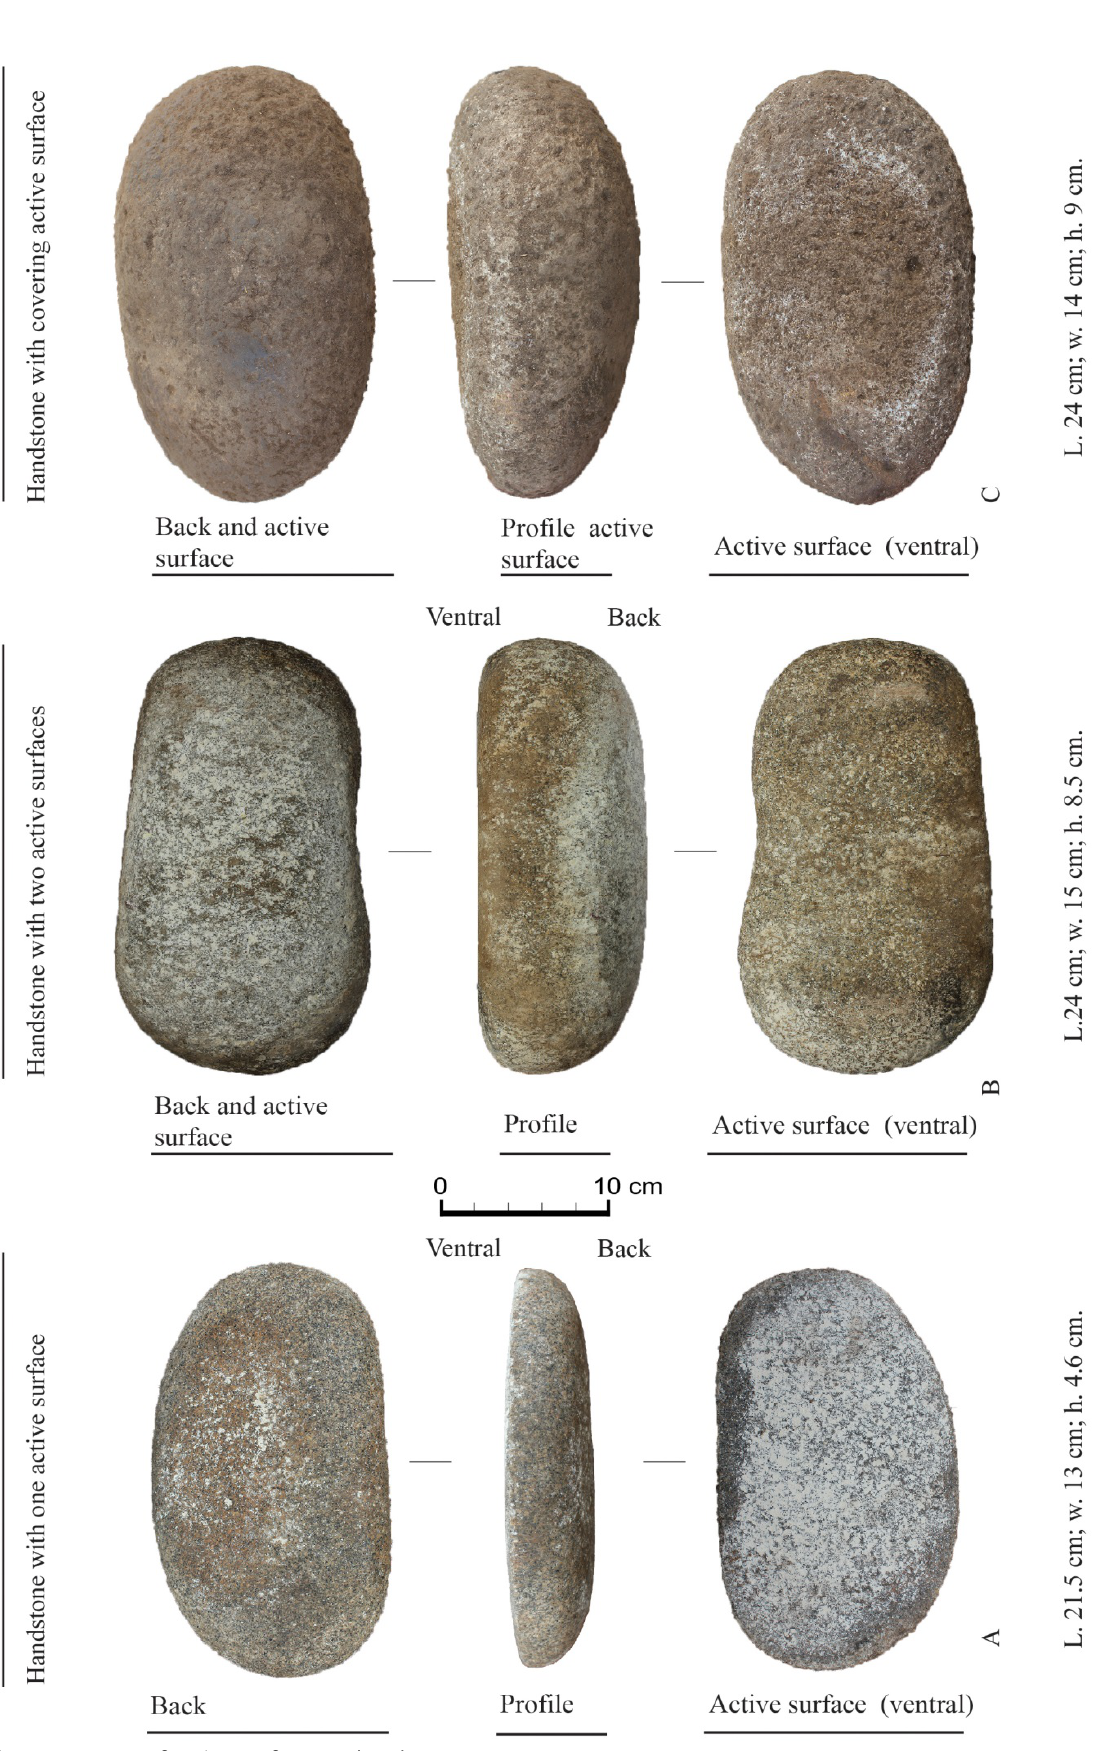
Figure 7. Types of active surfaces on